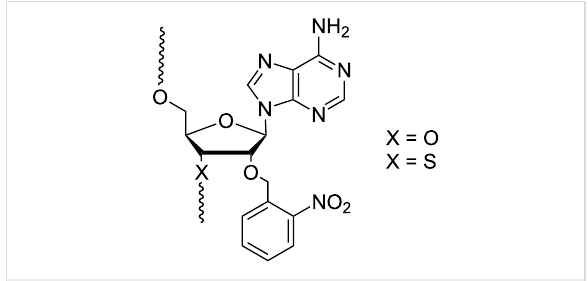
protecting groups within ON but are non-nucleoside moieties linking different ONs or both ends of the same ON together or ONs to other molecules. Most frequently, except for circular ONs, photoirradiation cuts the construct into small fragments that induce a change in the biological activity. Photolysis of cir- cular ONs provides linear full-length ONs. Compared to caged nucleobases that directly interact with their nucleic acid targets, photosensitive linkers do not interact but can organize the ONs into specific structures capable of or not interfering with their nucleic